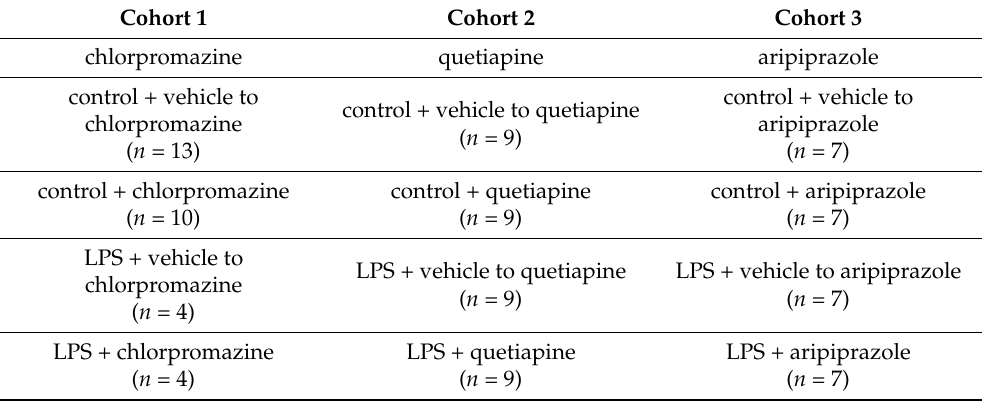
Table 1. The groups of the offspring generated and subsequently subjected to the administration of the antipsychotic drugs. The number of animals in each group is